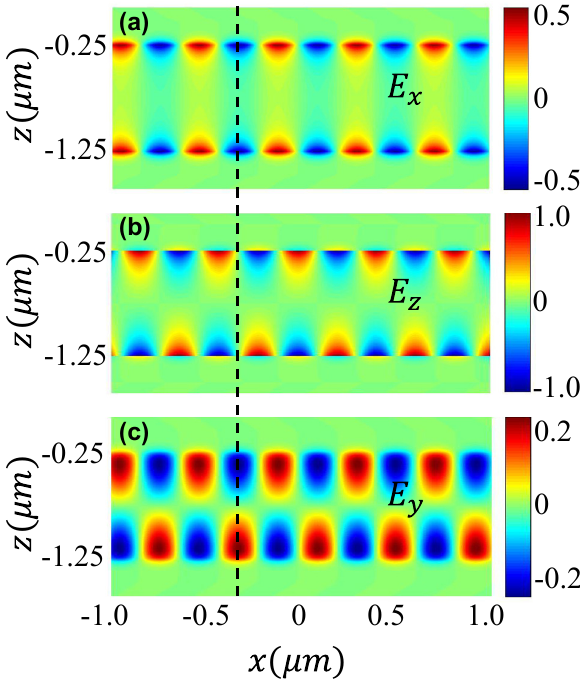
Figure 2: The dispersion relation of the wave number of the SPP as a function of the chirality. Here, 𝜆 𝜀 = 11.9. (a) d = 200 nm and d d c = 250 nm. d m